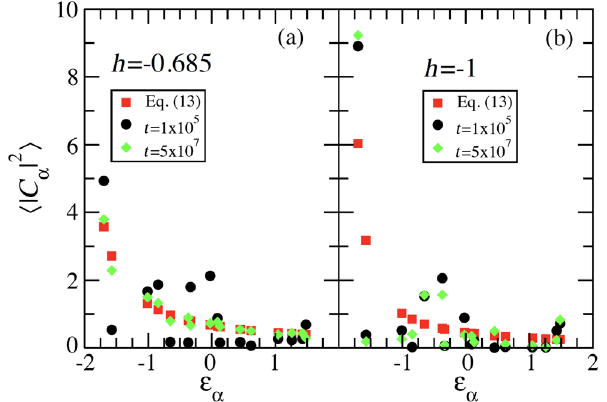
FIG. 5. Comparison between the time-averaged supermode optical powers fora multimode photonic network whose dynamics is described by the Hamiltonian Eq. (4) with random connectivity matrix Eq. (15) with J 0 ¼ 0 and σ ¼ 1 and the theoretical results (redsquares)ofEq.(13)forweakdisorder.Blackcirclescorrespond to moderate time evolutions with t ¼ 10 5 while green diamonds correspond to larger time evolutions with t ¼ 5 × 10 7 . The initial state has (a) high averaged energy density per mode h ¼ − 0 . 685 (corresponding to high temperatures) or (b) low averaged energy density per mode h ¼ − 1 (corresponding to moderate or low temperatures). In both cases the average optical power is a ¼ 1 . In these simulations, the number of modes is N ¼ 16 and the nonlinear parameter is χ ¼ 0 . 01